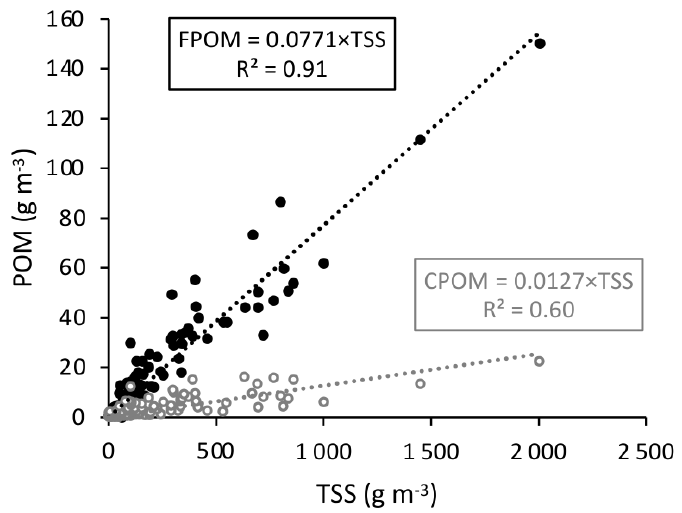
Figure 4. Instantaneous transport of CPOM (grey open dots) and FPOM (black dots) (g m − 3 ) in relation to TSS (g m − 3 ).